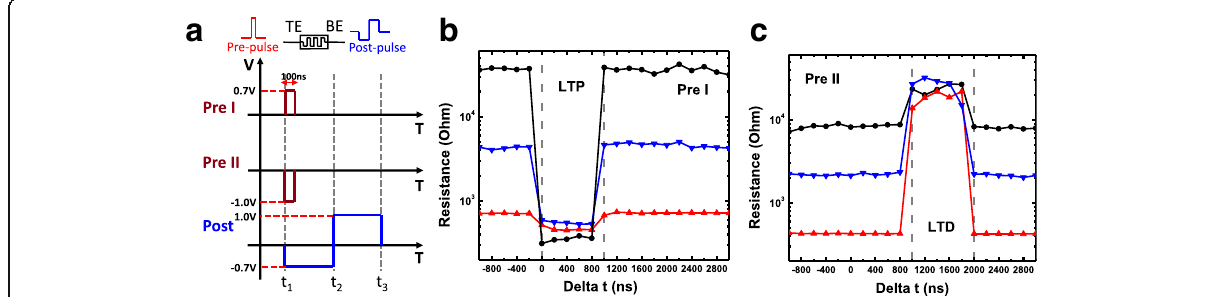
Fig. 4 A binary STDP protocol. a Waveforms used in this protocol. Including pre I, pre II, and post. b , c Measured binary STDP characteristics. LTP and LTD are determined by pre type and delta t